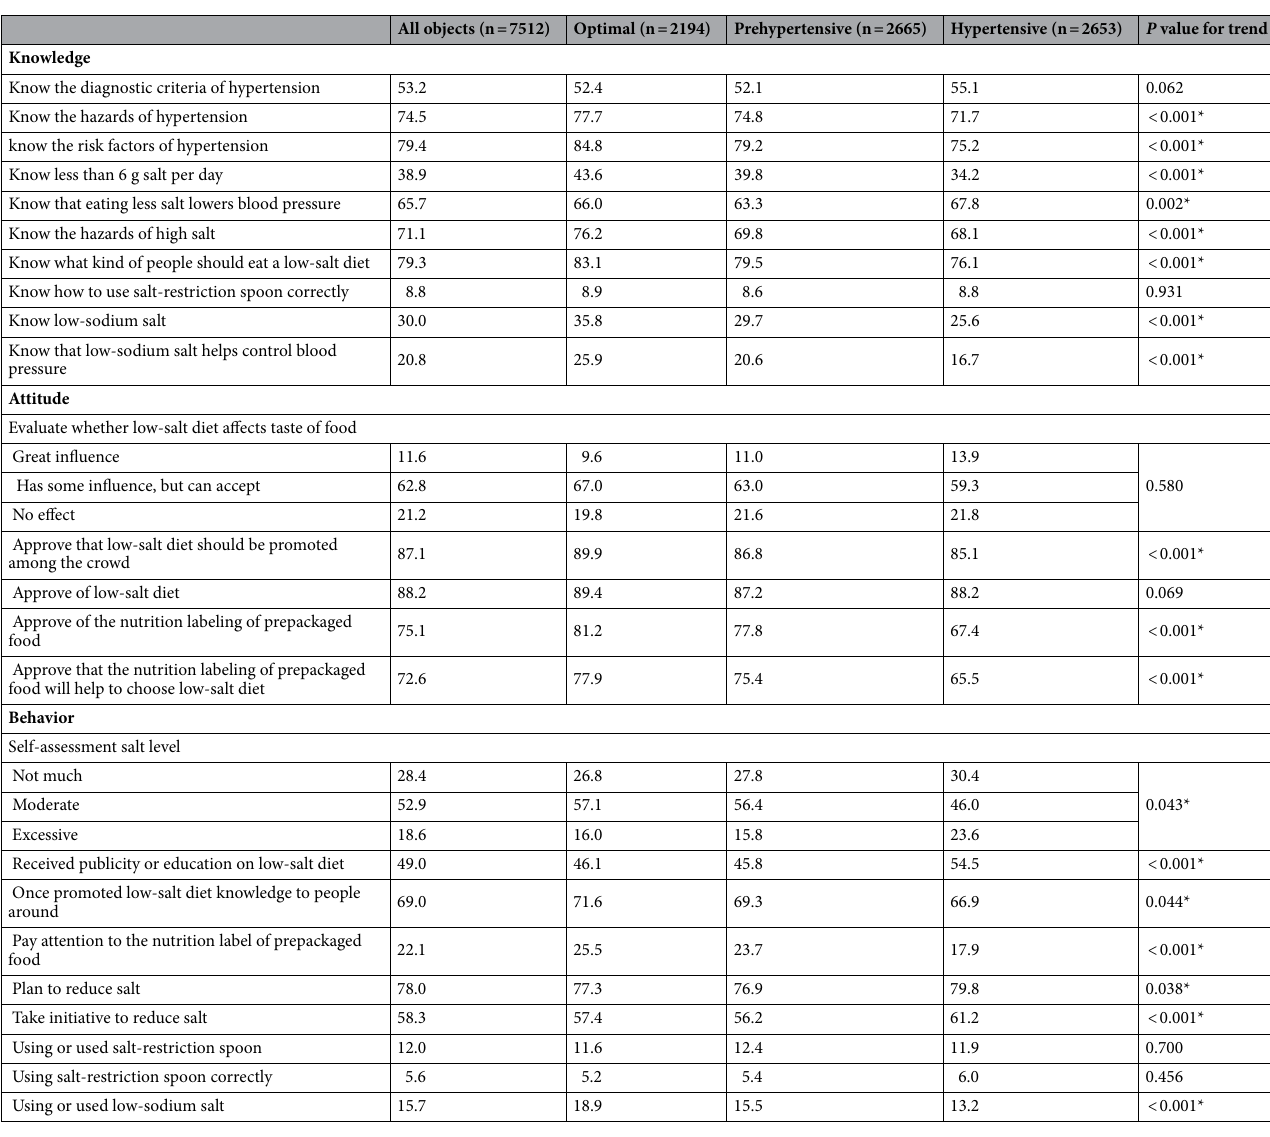
Table 3. Knowledge, attitudes, and behaviors related to salt among different hypertensive status, SRHPP 2017–2018: %. * P <